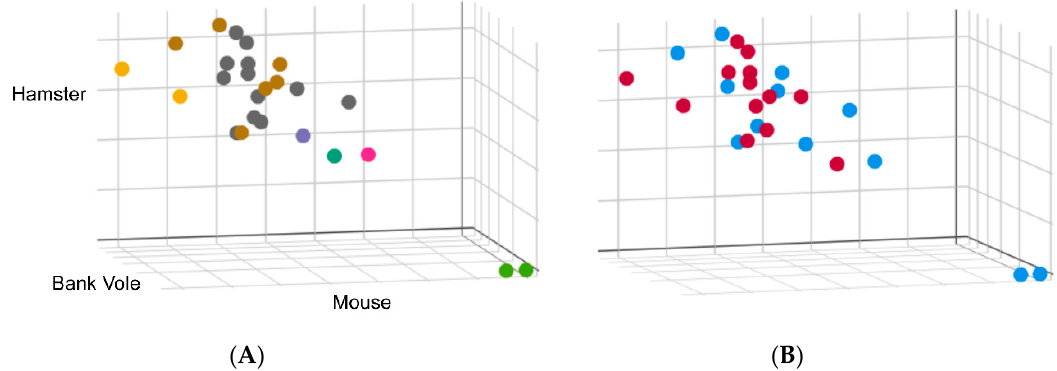
Figure 3. Real-time quaking-induced conversion (RT-QuIC) was performed on 10 − 4 dilutions of brain homogenate from 25 cases of sCJD using 3 di ff erent substrates: full-length mouse, hamster and bank vole. Conversion rate was measured by comparing the time at which fluorescence in a given reaction exceeds a pre-defined threshold, i.e., the lag phase. Lag phases for each case were normalized to a 263 K hamster brain homogenate run concurrently as a standard to allow direct comparison between each run. These values were plotted on a scatter plot where the axes represent the normalized lag phase for each substrate. ( A ) Cases were colored according to the biochemical subtypes: Type 1, shown in grey, and Type 2, shown in brown. Two cases where a mixture of Type 1 and Type 2 were identified are shown in yellow. Cases shown in green are two cases of variably protease sensitive prionopathy (VPSPr). A Type 1 case with a biochemically distinct denaturation profile is shown in green and two others that do not exhibit typical glycoform patterns by Western blot shown in pink and purple. ( B ) Data were colored to reflect RT-QuIC seeding from brains of CJD patients, with or without exposure to venison, shown as blue or red, respectively.